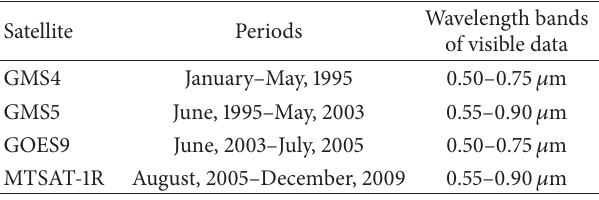
Table 1: Periods and wavelength bands of the satellite data used in this